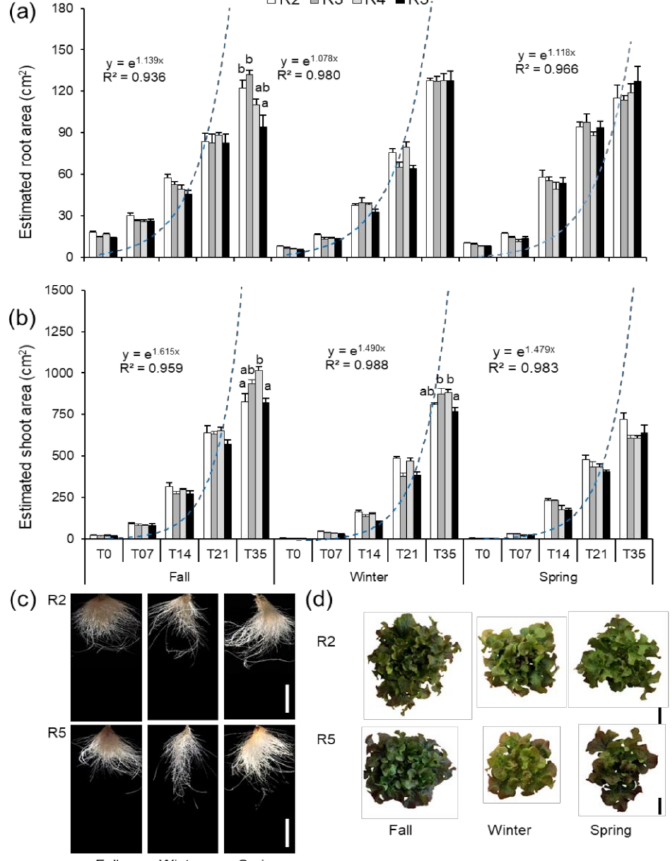
Figure 4. Quantitative analysis of root and shoot area in the studied ROAK genotypes during hydroponic growth. ( a ) Average root area (cm 2 ) and ( b ) average shoot area (cm 2 ) values in the studied lines (R2, R3, R4 and R5) between 0 (T0) and 35 (T35) dap. Theoretical exponential growth curves are depicted in blue. Different letters indicate significant differences between genotypes at 35 dap (LSD; p -value < 0.01). ( c , d ) Representative images of the root ( c ) and shoot ( d ) system of R2 and R5 genotypes at 14 and 21 dap, respectively. Scale bars: 50